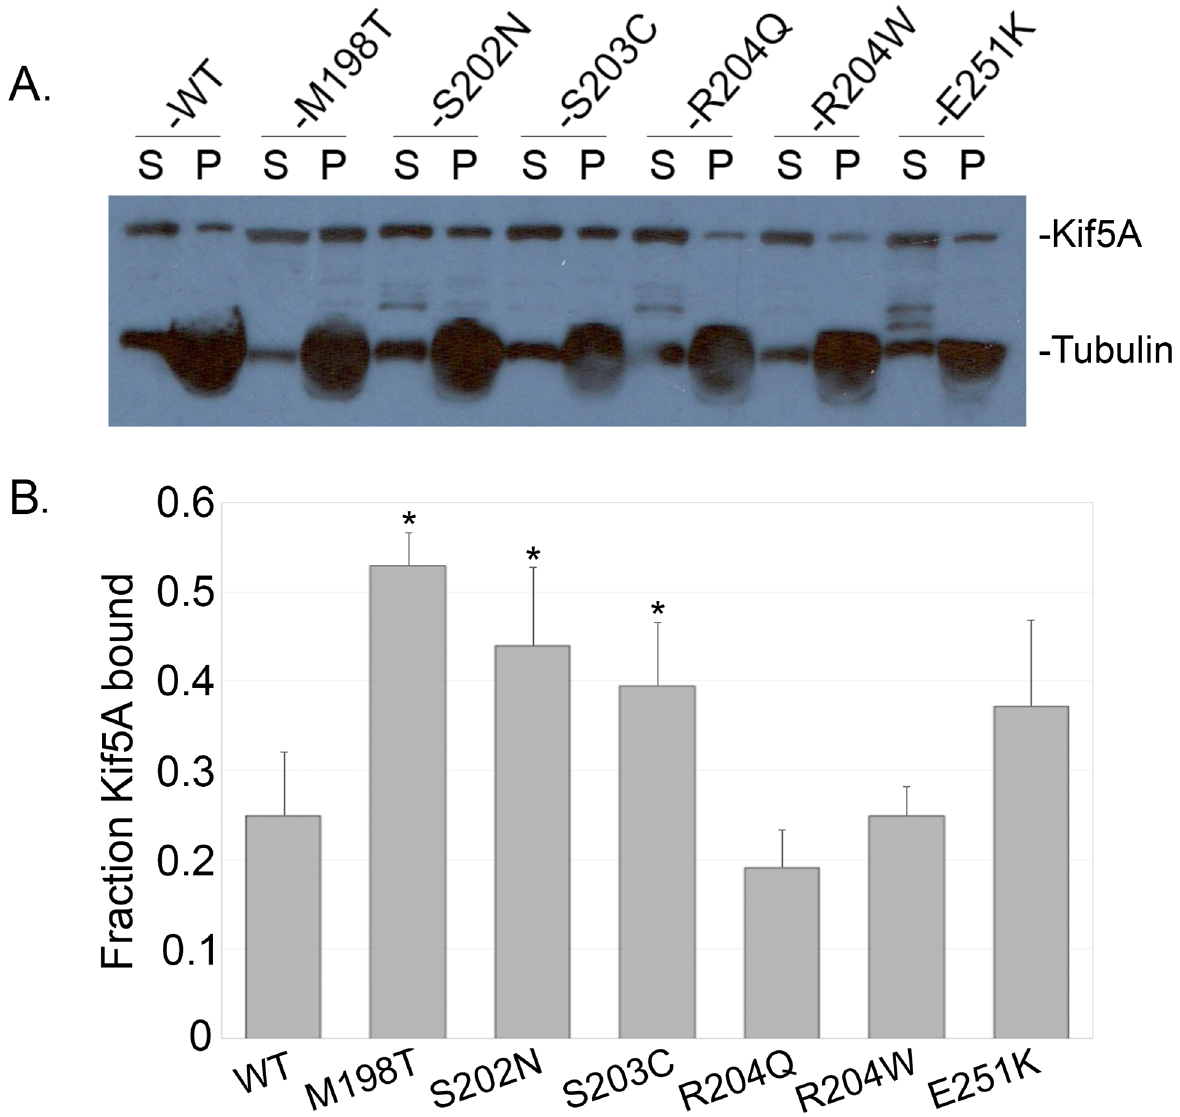
Fig 1. Microtubule affinity in the presenceof ATP. A) Samplewestern blot of a single microtubule pelletingassay. S indicatesthe supernatant fraction and P indicatesthe pellet that had been resuspended in a volume of buffer equal to that of the supernatant. B) Quantitationof the averageband densitometry of the pellet fraction from three separatemicrotubule pelleting assays for each Kif5A construct. Error bars show one standarddeviation.Asterisks indicate a significantincreaseof kinesinin the microtubule-boundpellet fraction (p <